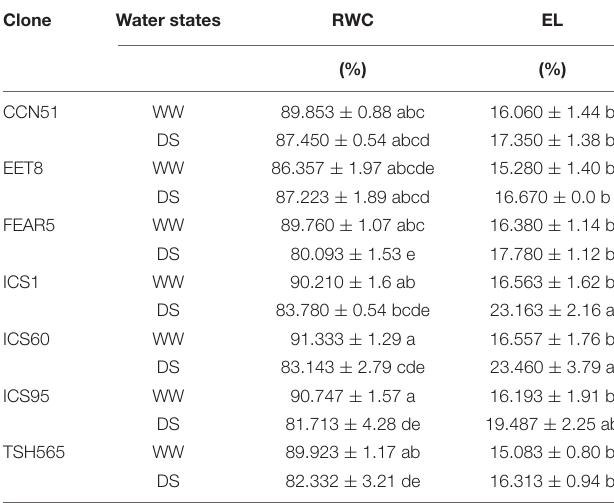
TABLE 4 | Changes in the leaf relative water content (RWC) and electrolyte linkage (EL) at D26 in the seven cacao